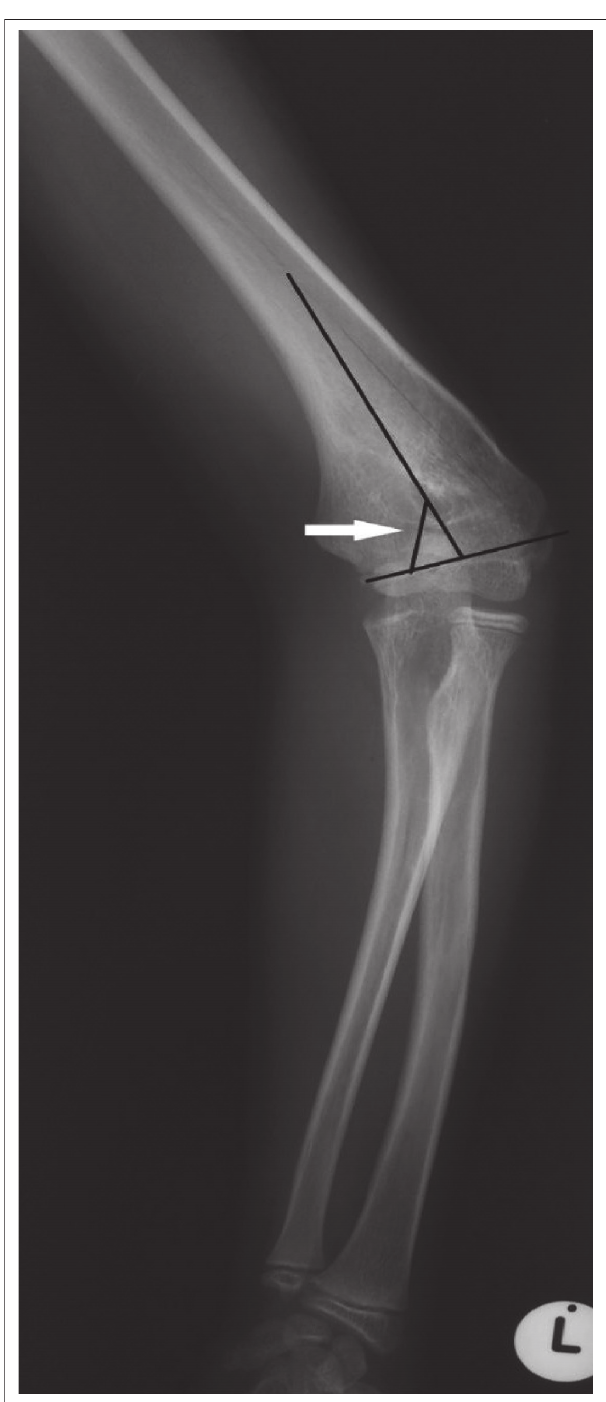
FIGURE 8: Baumann’s angle (shown) is formed by the intersection of a line drawn perpendicular to the humeral shaft and a line along the physis of the lateral condyle. A normal Baumann’s angle within the paediatric population ranges from 85 – 89 degrees. It is important to compare angles between the normal and abnormal side, a difference of more than 5 degrees predicts a possible varus deformity.